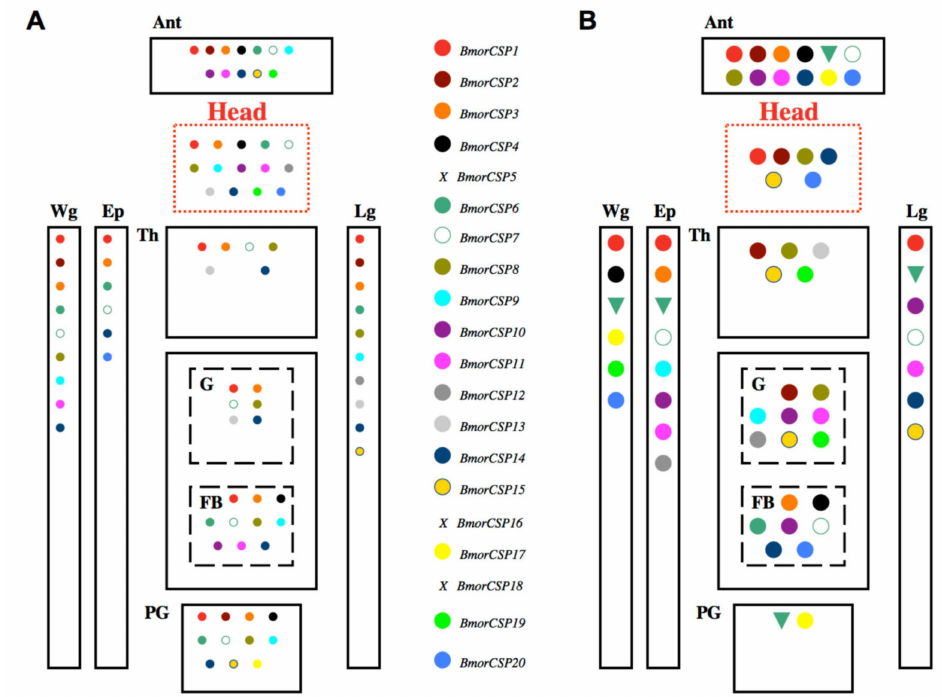
Figure 5. Tissue expression profiling of CSPs . B. mori CSP gene expression profiling under normal conditions ( A ) and following exposure to abamectin insecticide ( B ). Data are from Xuan et al. [13,14]. Specific gene expression is shown by color code. X indicates no expression for truncated genes ( BmorCSP5 , BmorCSP16 and BmorCSP18 ). Up regulation in the expression levels of CSP genes is indicated by a larger circle. Down regulation in the expression levels of CSP gene ( BmorCSP6 ) is indicated by a triangle oriented down. Ant: Antennae, Ep: Epidermis, FB: Fat Body, G: Gut, Lg: Legs, PG: Pheromone Gland, Th: Thorax, Wg: